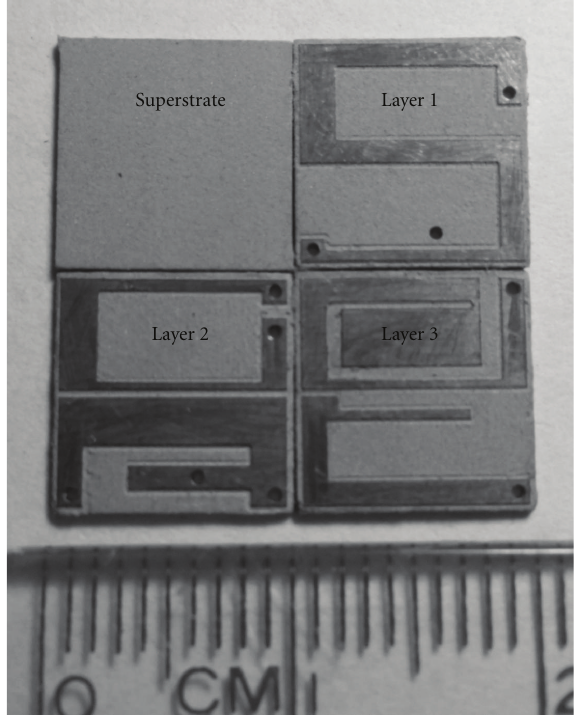
Figure 10: Fabricated quad-band implantable PIFA